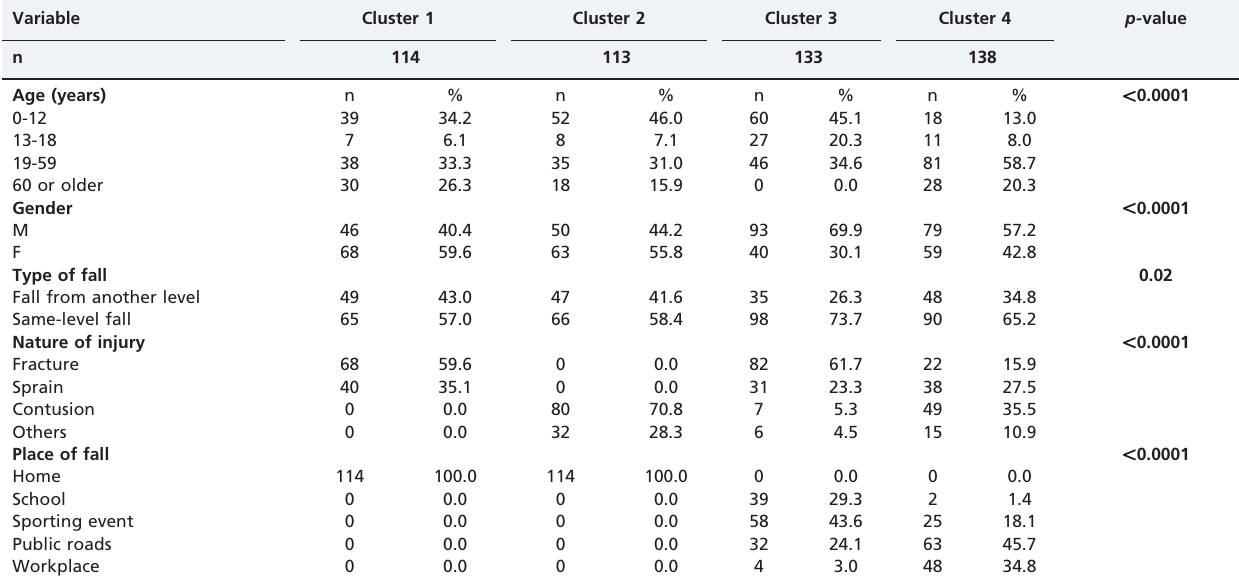
Table 5 - Analysis of variables with respect to their ability to differentiate among victim clusters. Sergipe, Brazil, 2010.